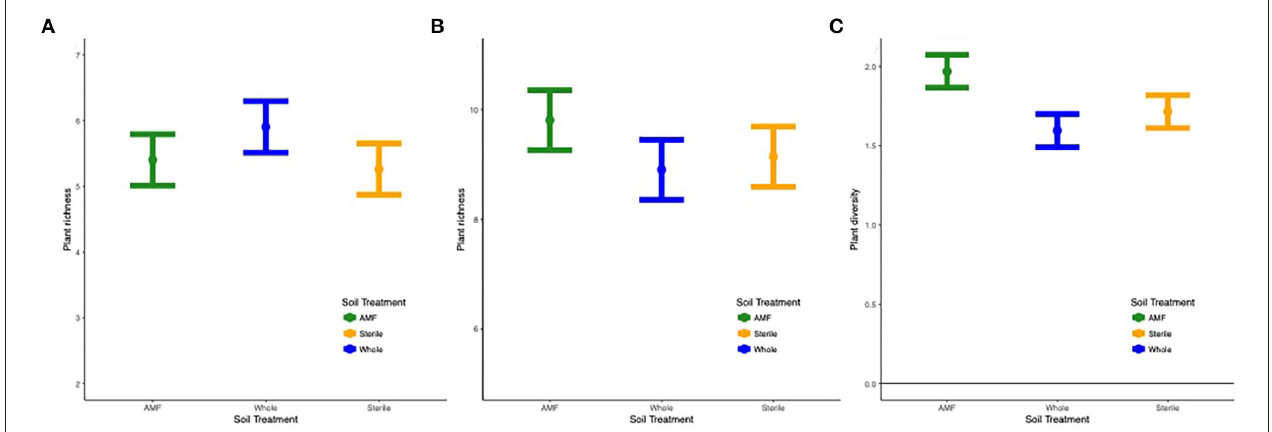
FIGURE 6 | (A) Plant richness across the three soil treatments in (A) Tinker site across all years and (B) Ft. Riley B. bladhii site in year 1 and (C) diversity in Ft. Riley B. inermis site in year 3.